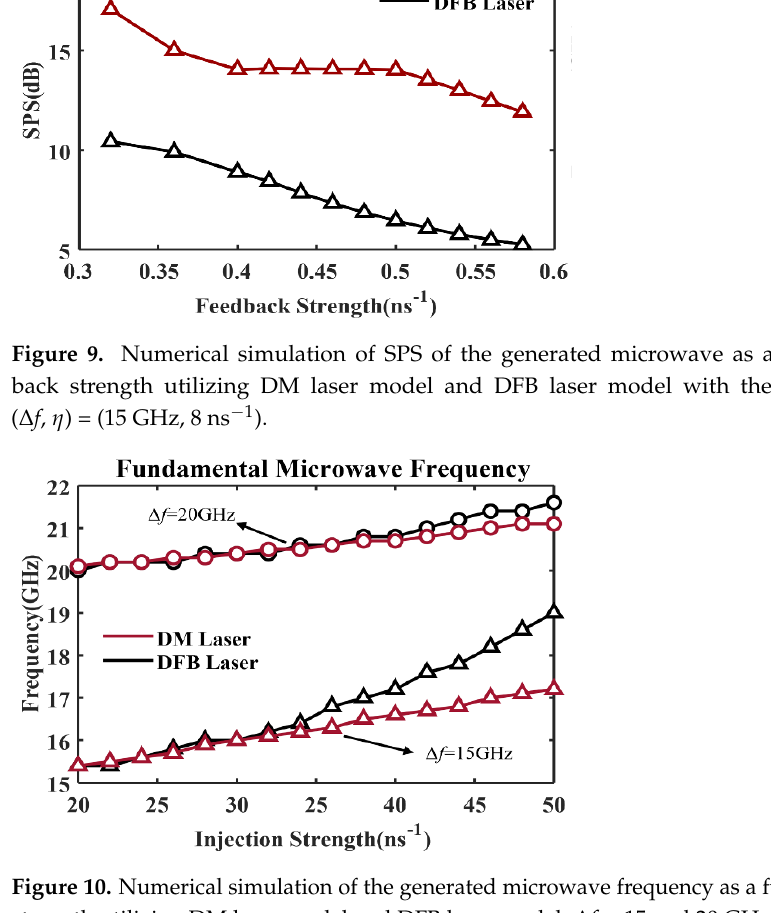
Figure 9. Numerical simulation of SPS of the generated microwave as a function of the feedback strength utilizing DM laser model and DFB laser model with the injection parameters ( Δ f , η ) = (15 GHz, 8 ns − 1 ).